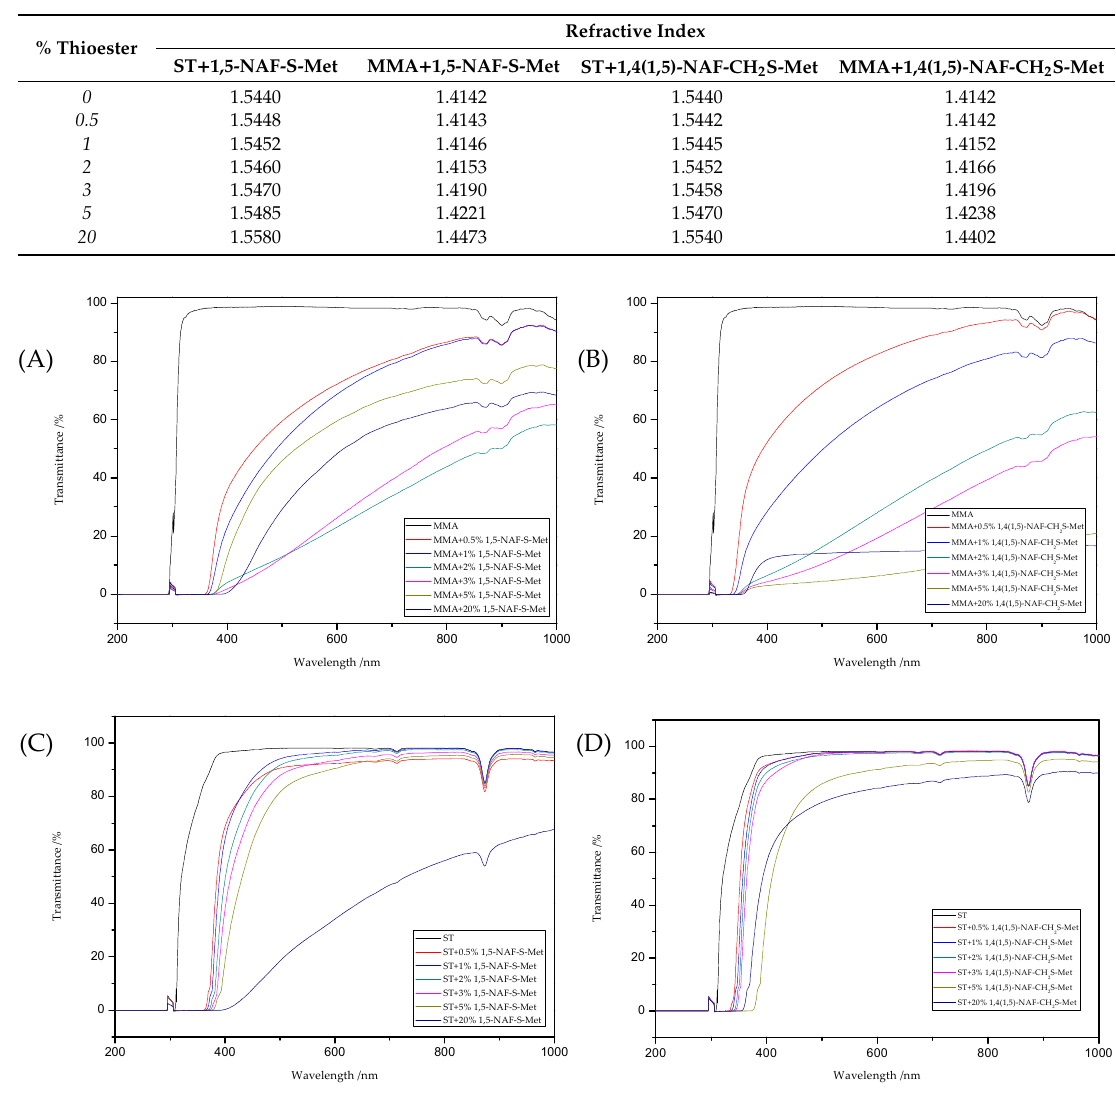
Table 5. Optical properties.